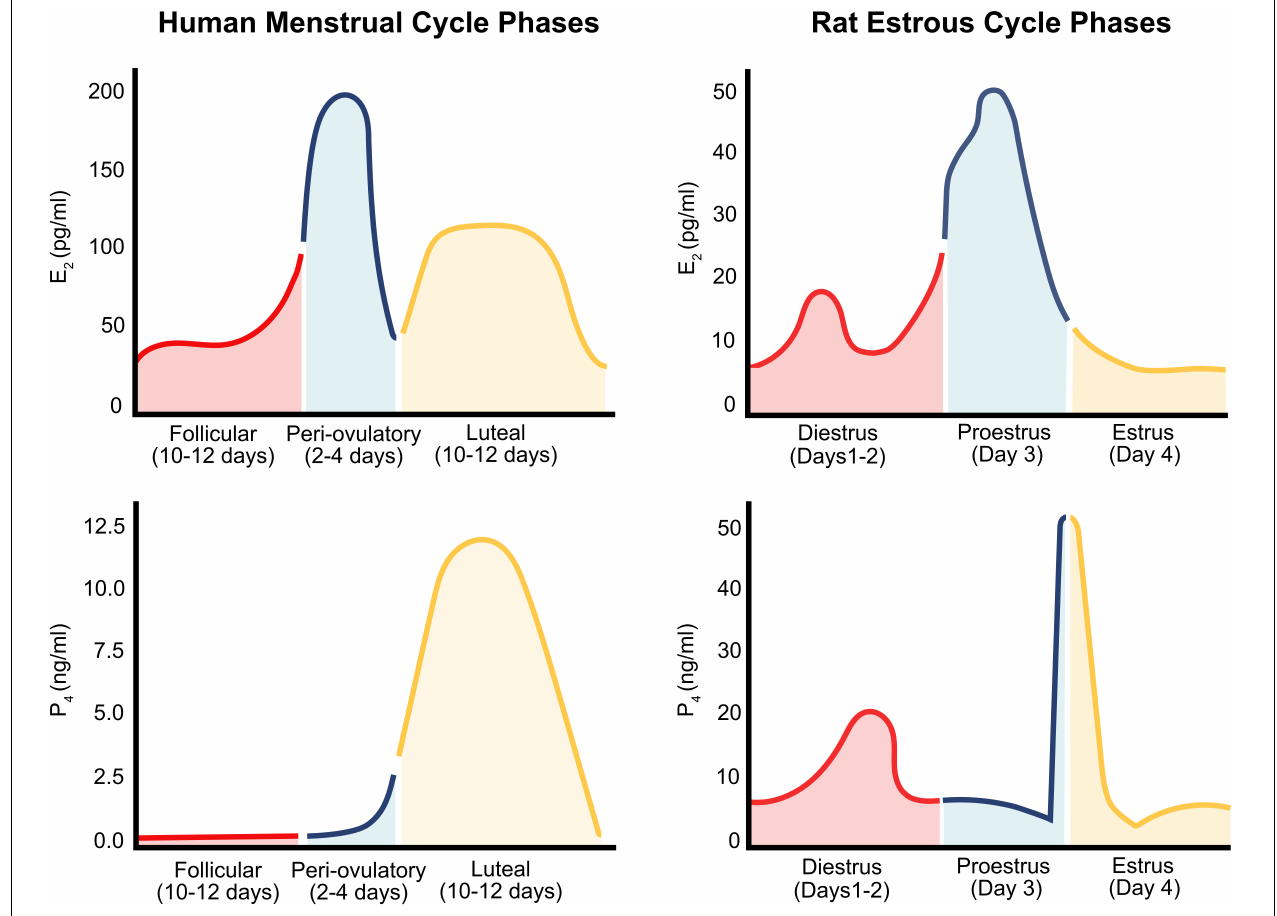
FIGURE 2 | The human menstrual cycle and rat estrous cycle. The human menstrual cycle (left) occurs over 28 days and is comprised of fluctuating levels of E2 (E2); (top) and progesterone (P4; bottom). Levels of E2 rise to a peak during the peri-ovulatory phase. E2 levels then drop, rise, and plateau between during the mid-luteal phase (approximately Days 14–28). Progesterone (P4) levels begin to at the end of the ovulation (Days 0–14) and reach their peak during the mid-luteal phase of the cycle (approximately Day 7). The rat estrous cycle (right) is similar to the human menstrual cycle but occurs over a 4/5-day period. Four phases; metestrus, diestrus, proestrus, and estrus comprise the rat estrous cycle. Estrogen levels (top) peak toward the end of diestrus and beginning of proestrus. Progesterone levels (bottom) reach a peak during